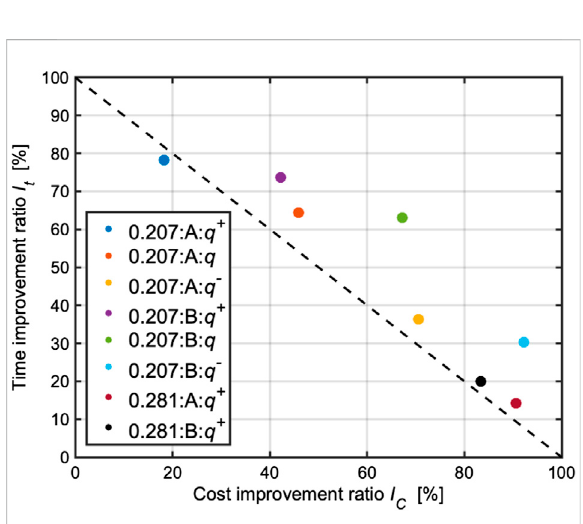
FIGURE 15 Summary of two metrics ( I C vs. I t ) in the simulation results. The legend shows a set of terrain roughness, goal, and planning stop criterion. The dashed line describes the benchmark of the relationship between I C and I t . For instance, if the trajectory planning stops at an 80% cost improvement of the nearly optimal trajectory planner, it stands to reason that a 20% time improvement would be